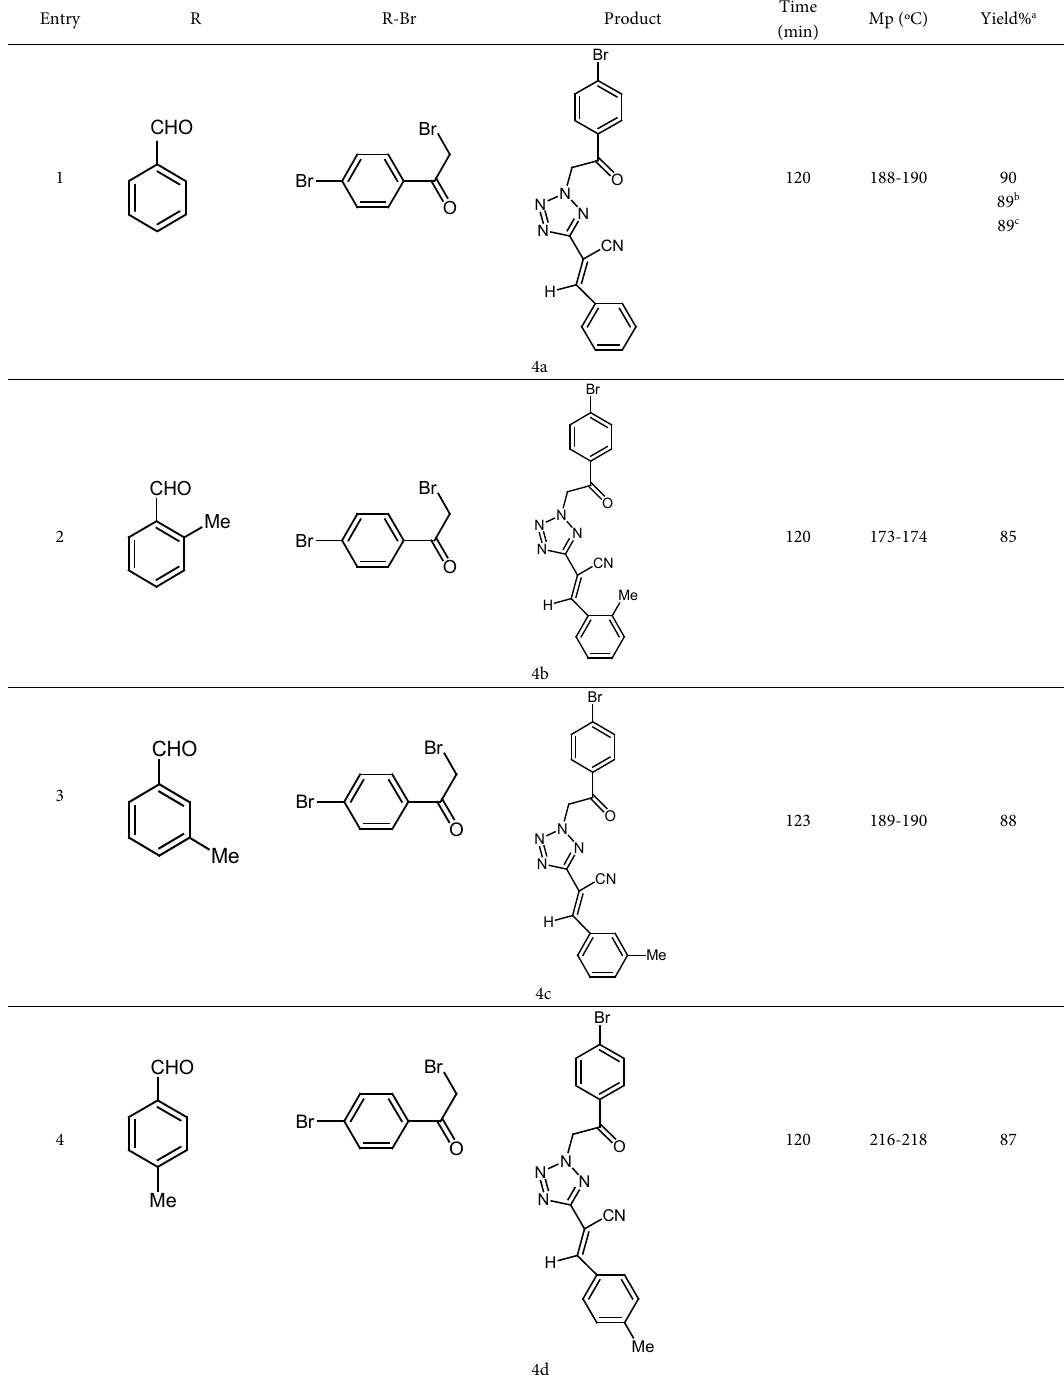
Table 1. Synthesis of disubstituted tetrazoles catalyzed by NiO NPs (6 mol%) at 70ºC in DMF